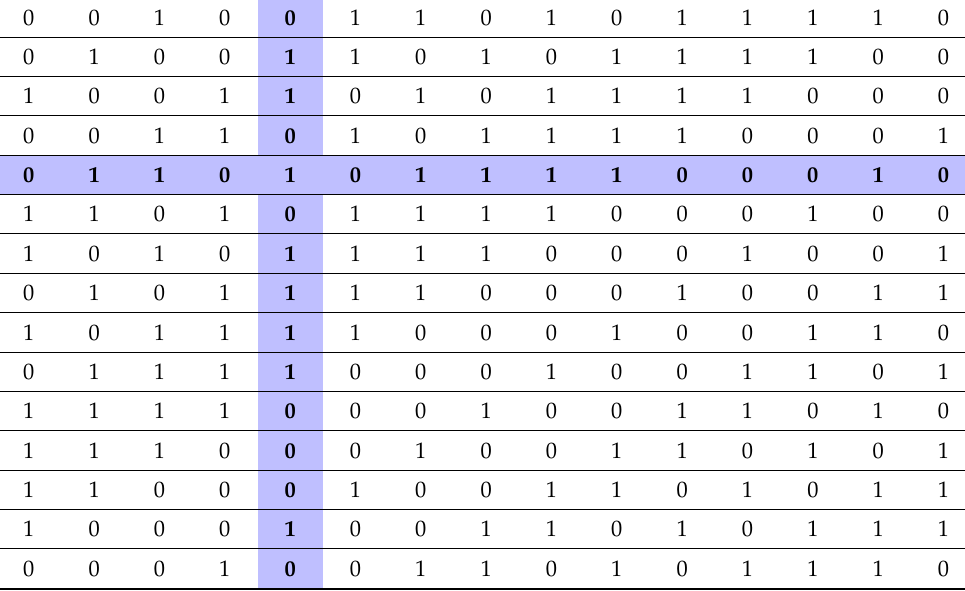
Table 2. The first row shows the sequence of 2 4 − 1 bits Y 3 ( c ) generated by a 4-bit ALFSR whose initial seed is selected randomly. Each following row is equal to the previous one left-shifted by 1 position. The resulting array is symmetrical since, by construction, any i th row and column are